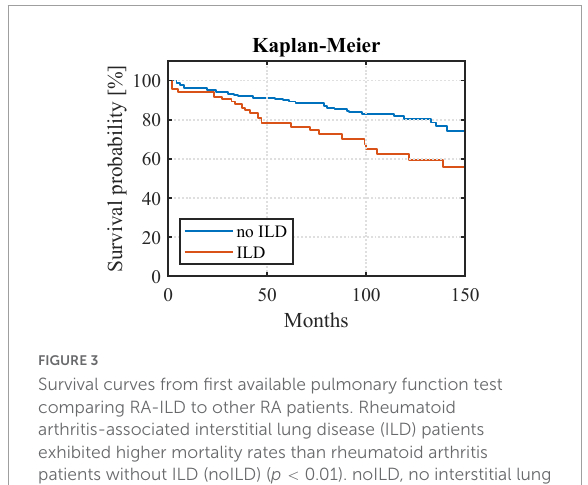
FIGURE3 Survival curves from first available pulmonary function test comparing RA-ILD to other RA patients. Rheumatoid arthritis-associated interstitial lung disease (ILD) patients exhibited higher mortality rates than rheumatoid arthritis patients without ILD (noILD) ( p < 0.01). noILD, no interstitial lung disease; ILD, interstitial lung